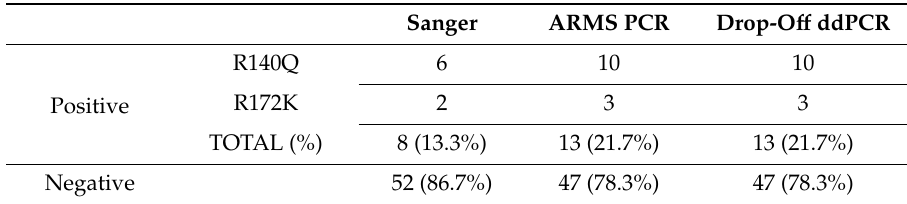
Table 1. Isocitrate dehydrogenase 2 (IDH2) mutational status